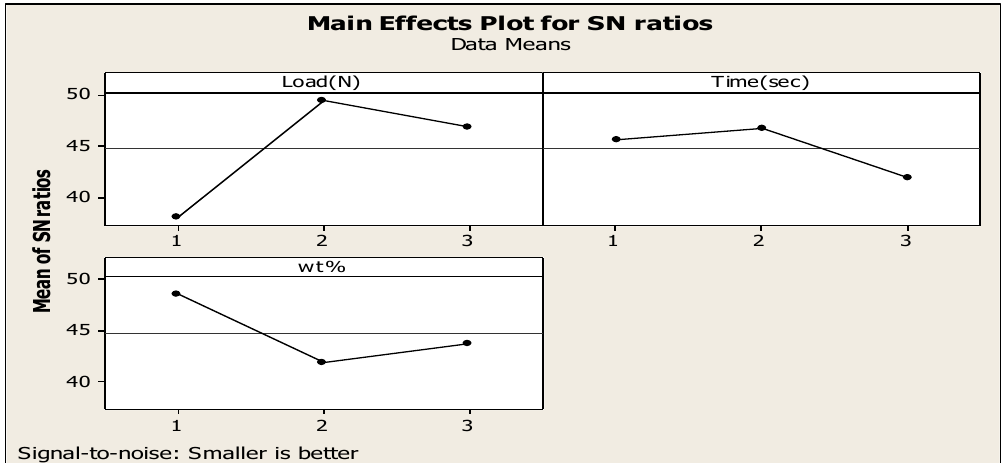
Signal-to-noise: Smaller is Figure 17: Main effect plots for SN ratio - Wear rate at high speed. Source: Authors, (2022).